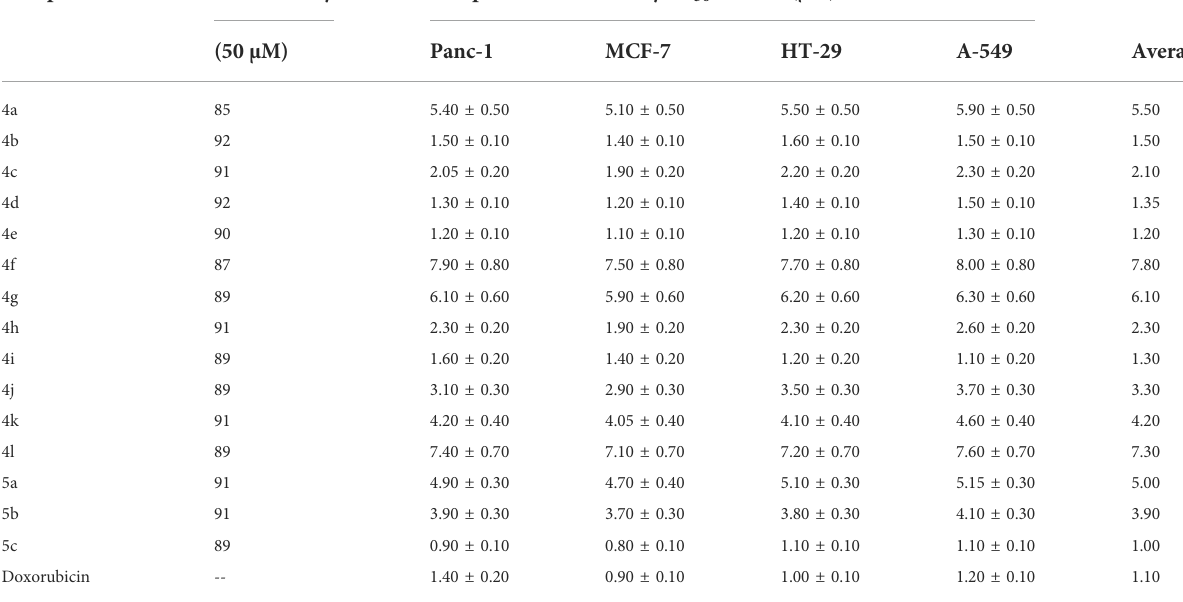
TABLE 1 IC 50 of compounds 4a-l, 5a-c, and Doxorubicin. Compd. No.